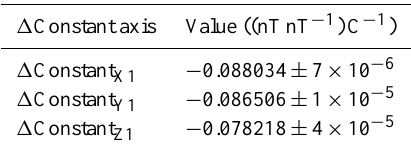
Table 12. Sensor 1 offset coils characterization with temperature.